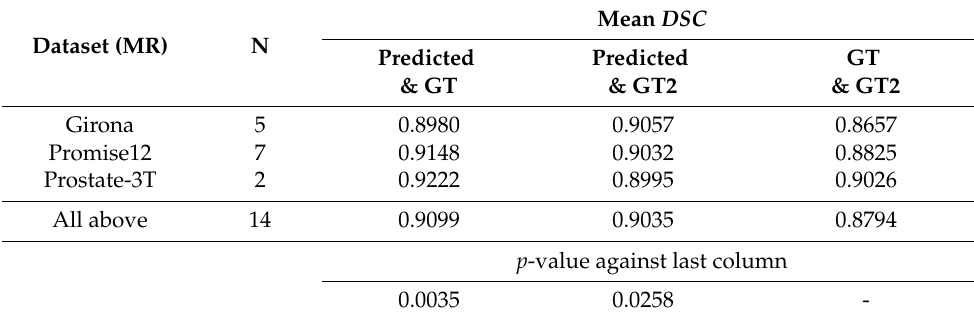
Table 3. Evaluation of the predictions against GT and GT2, as well as GT against GT2 (inter-expert